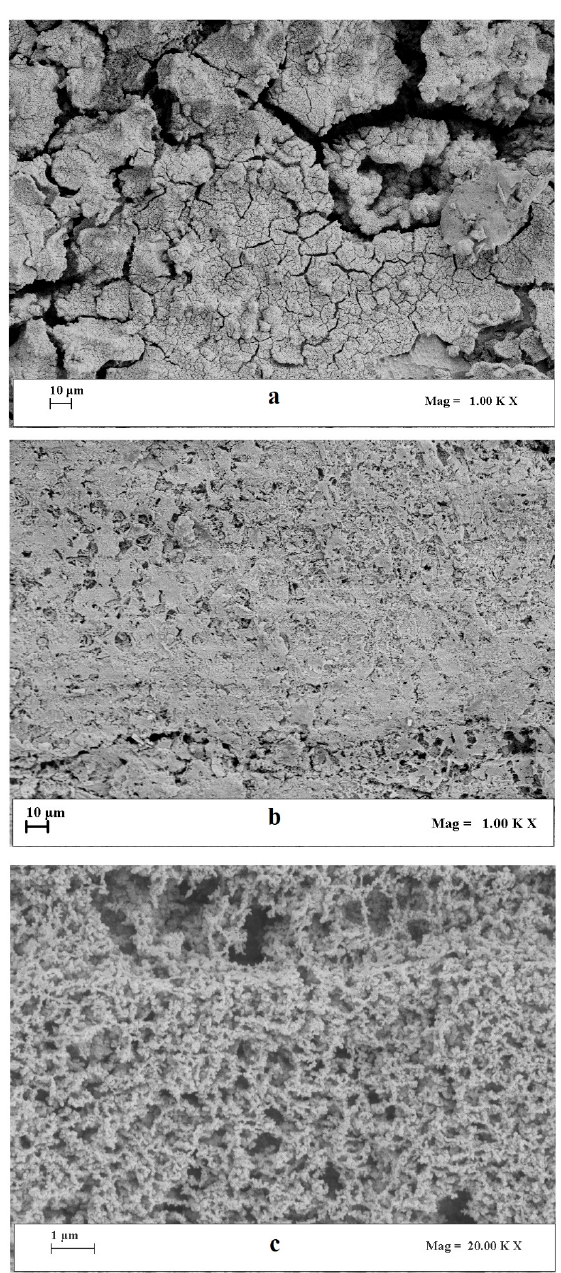
Figure 8. SEM (scanning electron microscopy) image of S1 structured catalyst at different magnitude ( a , c ), and a SEM image of a structured catalyst obtained by washcoating and loaded with Pt/Re/CeZrO 4 catalytic formulation ( b ).